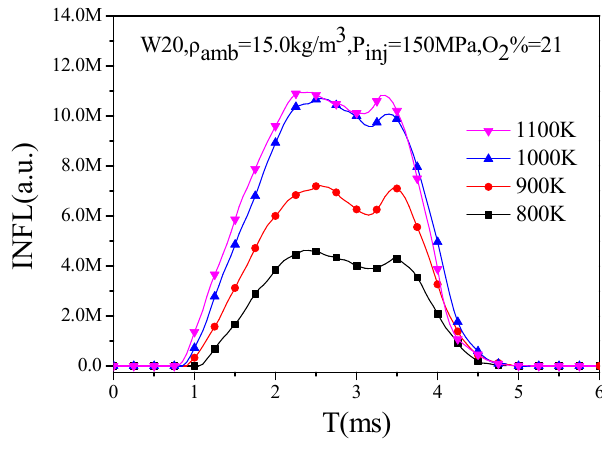
Figure 10. Variation of INFL with time .